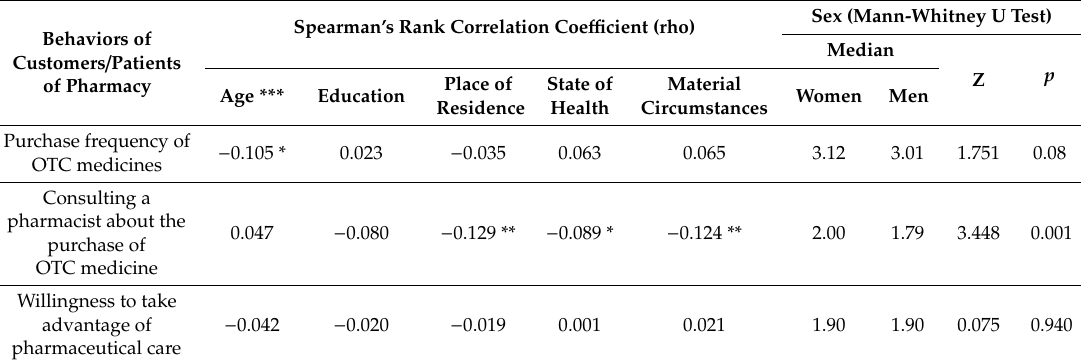
Table 2. Sociodemographic variables and the behaviors of customers / patients coming into contact with